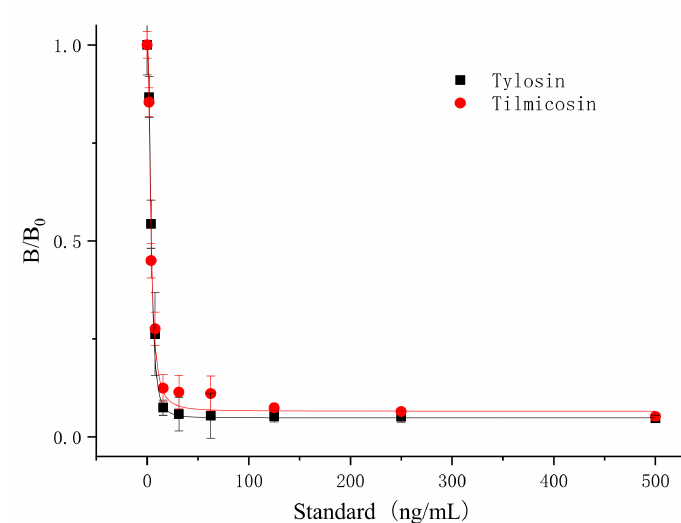
Figure 10. Standard curves for T&T in milk using TRFICA ( n =